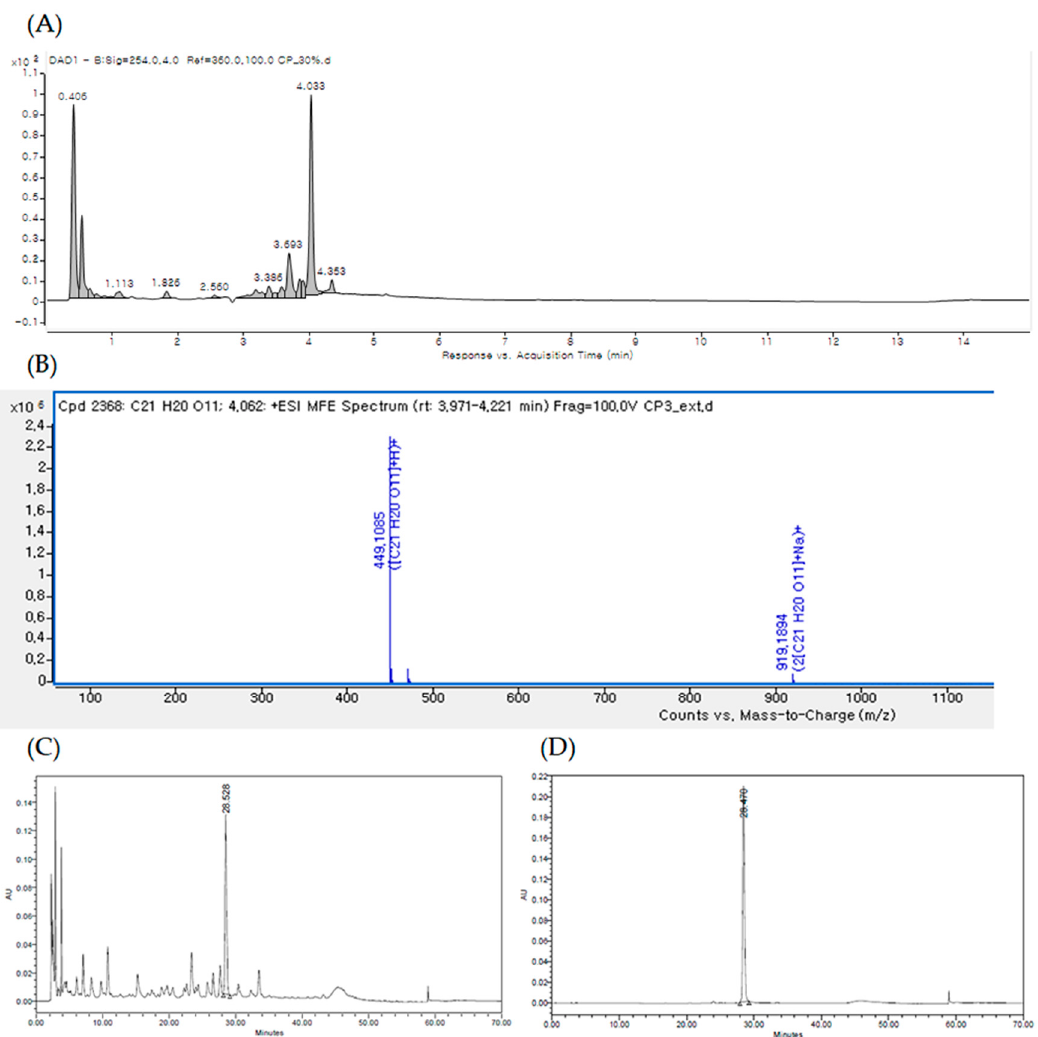
Figure 1. ( A ) UPLC of the ethanol extract of C. mimosoides var. nomame Makino (EECM) detected at 254 nm. ( B ) High-resolution mass spectrometry (HR/MS) spectrum of [M + H] ions (m/z 499) of quercitrin (Rt: 4.033 min). High-performance liquid chromatography (HPLC) profiles of ( C ) EECM and ( D ) standard quercitrin.